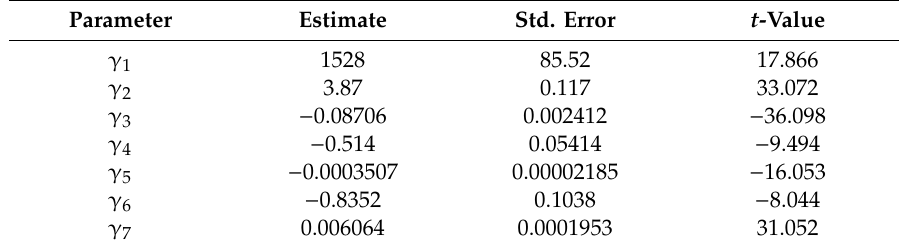
Table 5. Parameter estimates of model from Equation (11) and their standard error and t -value.